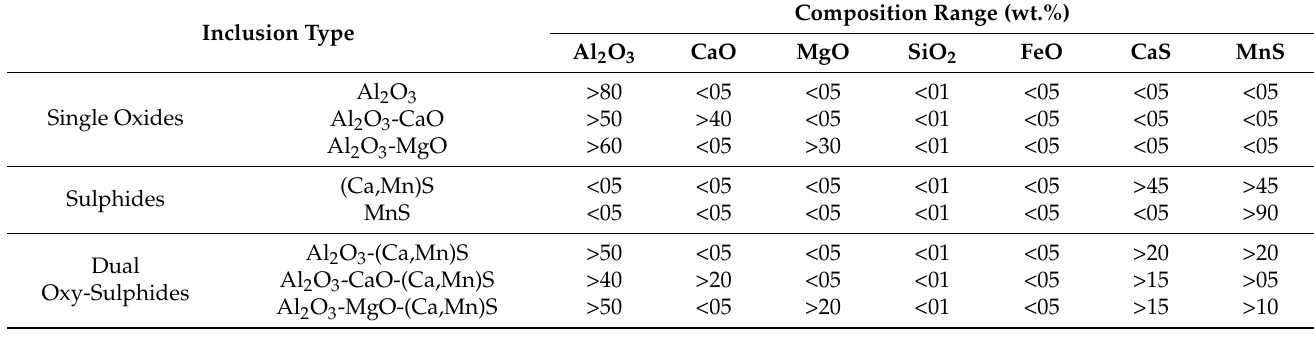
Table 2. Classification of inclusions in both samples based on the chemical compositions and mor- phologies.